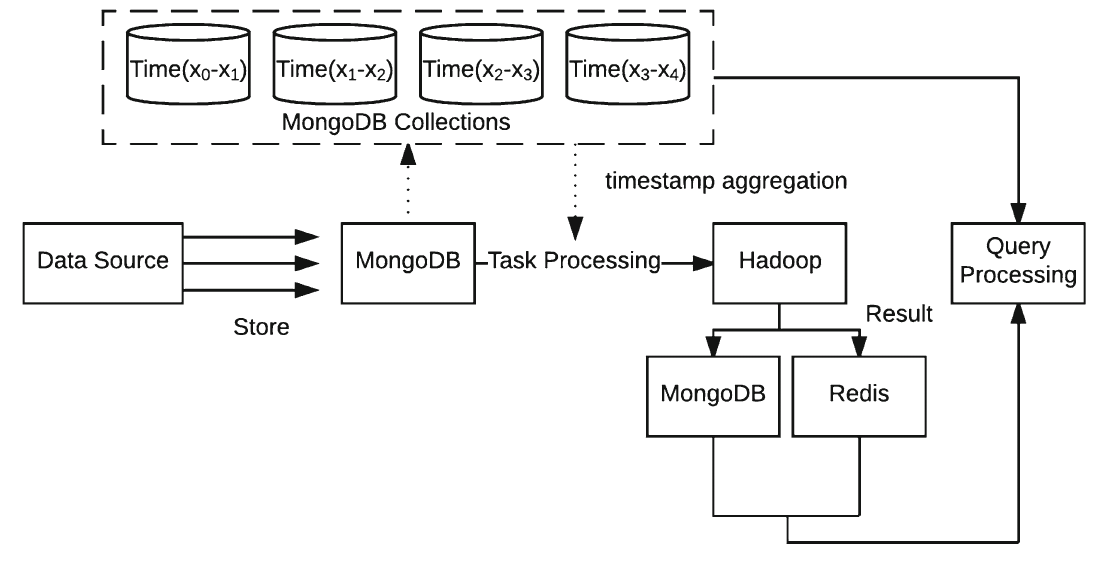
Fig. 1 Pre-computing